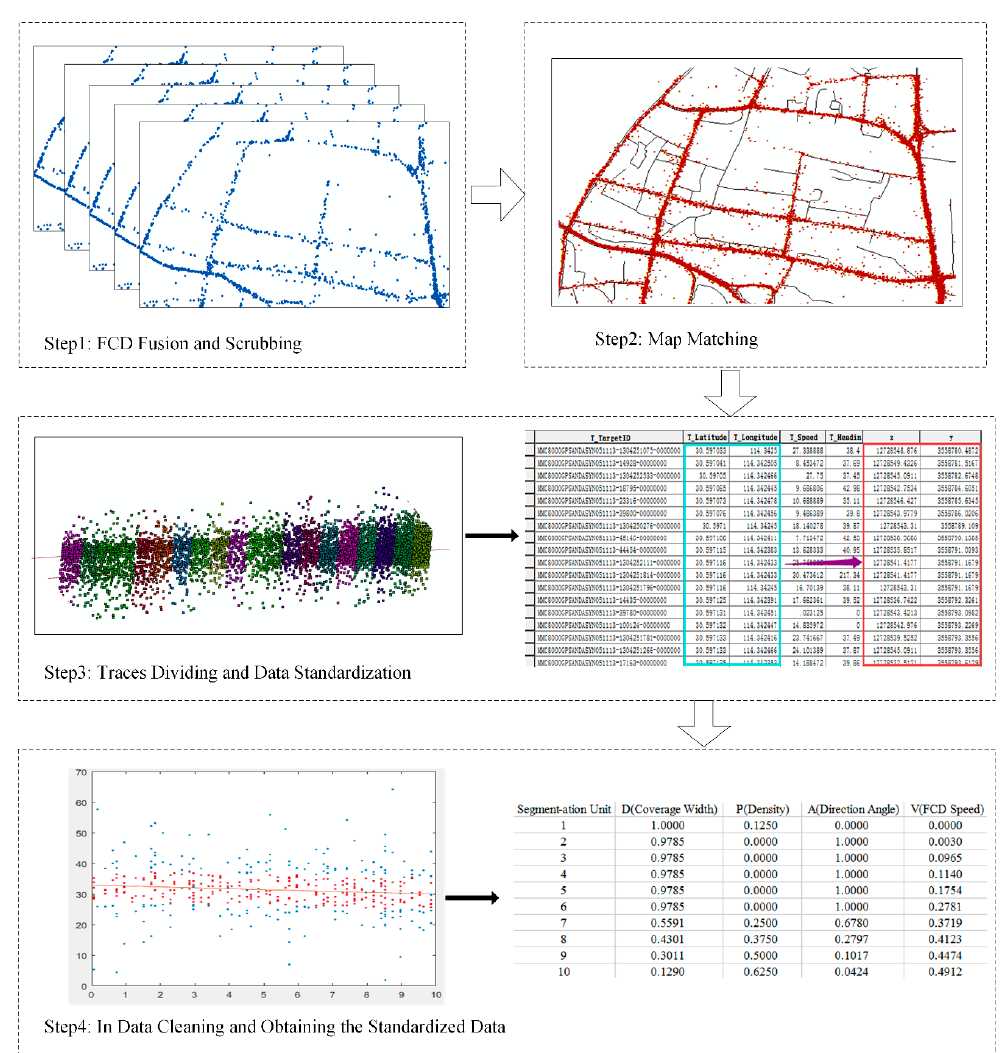
Figure 6. Experimental data processing flow.